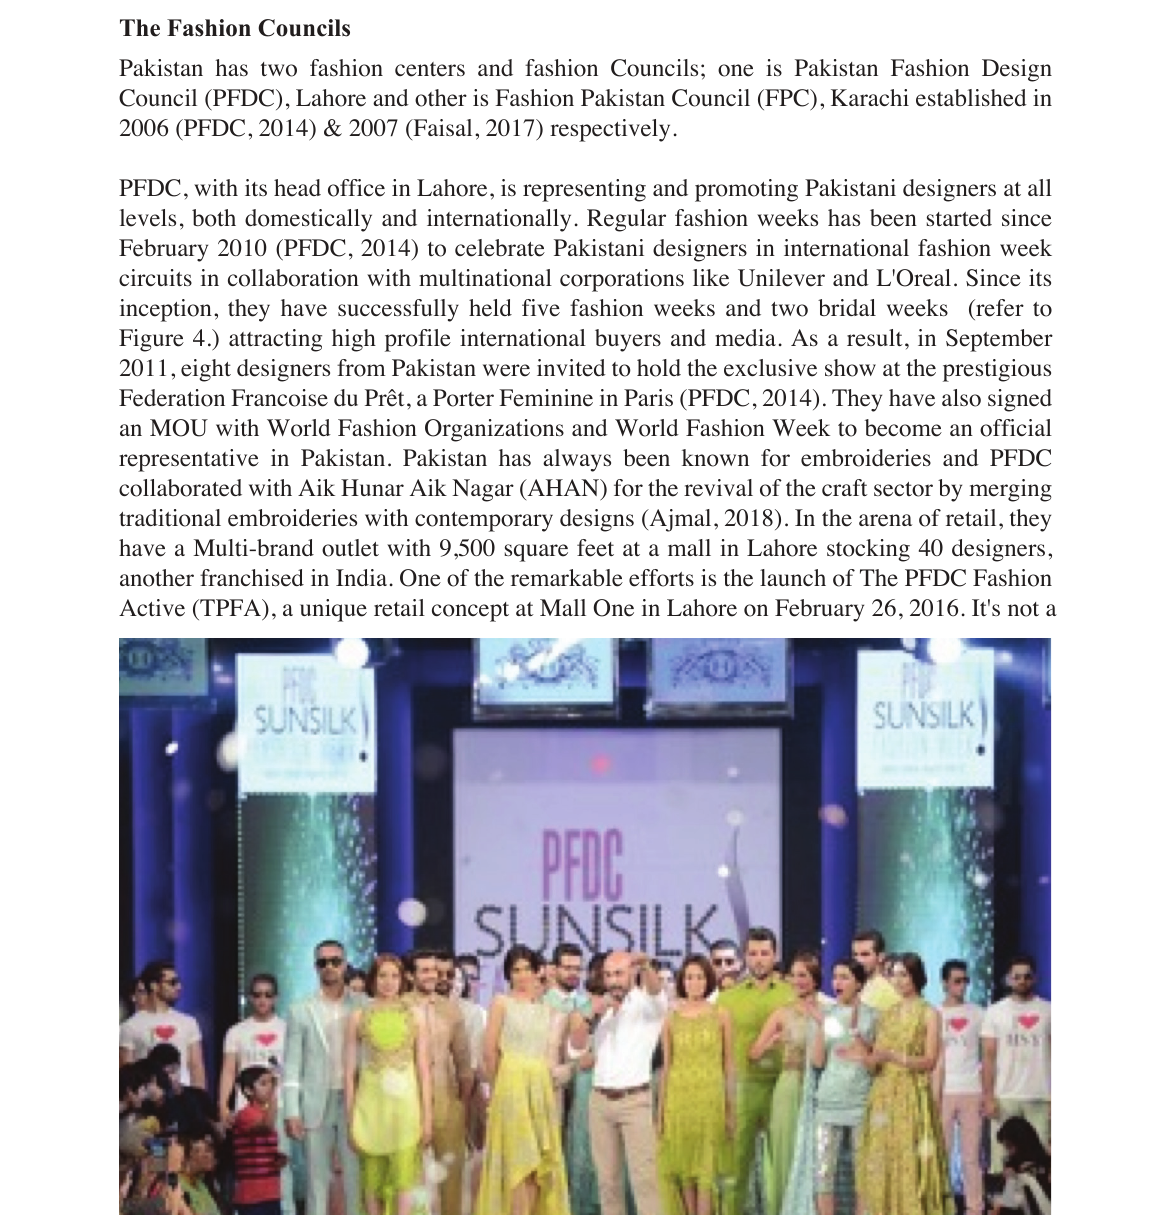
Figure 3: Pakistani designer at a fashion show organized by PFDC Source: Express